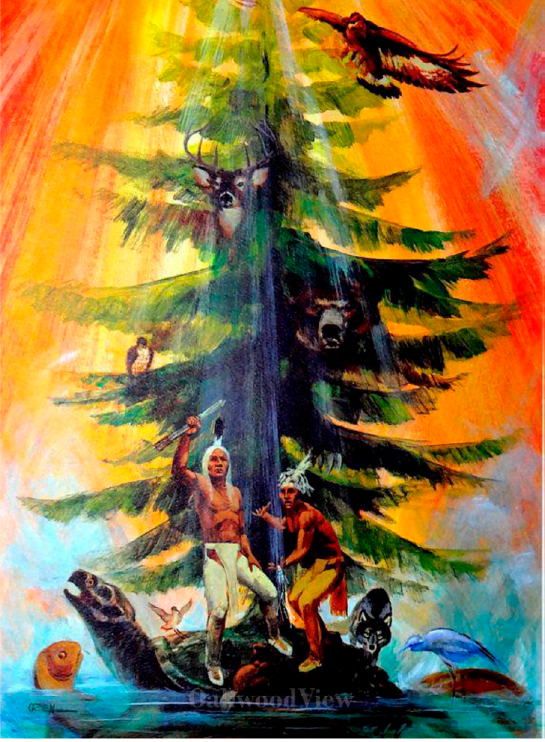
Figure 13. Oren Lyons, Great Tree of Peace , 1971. Oil on canvas, with permission of the artist.